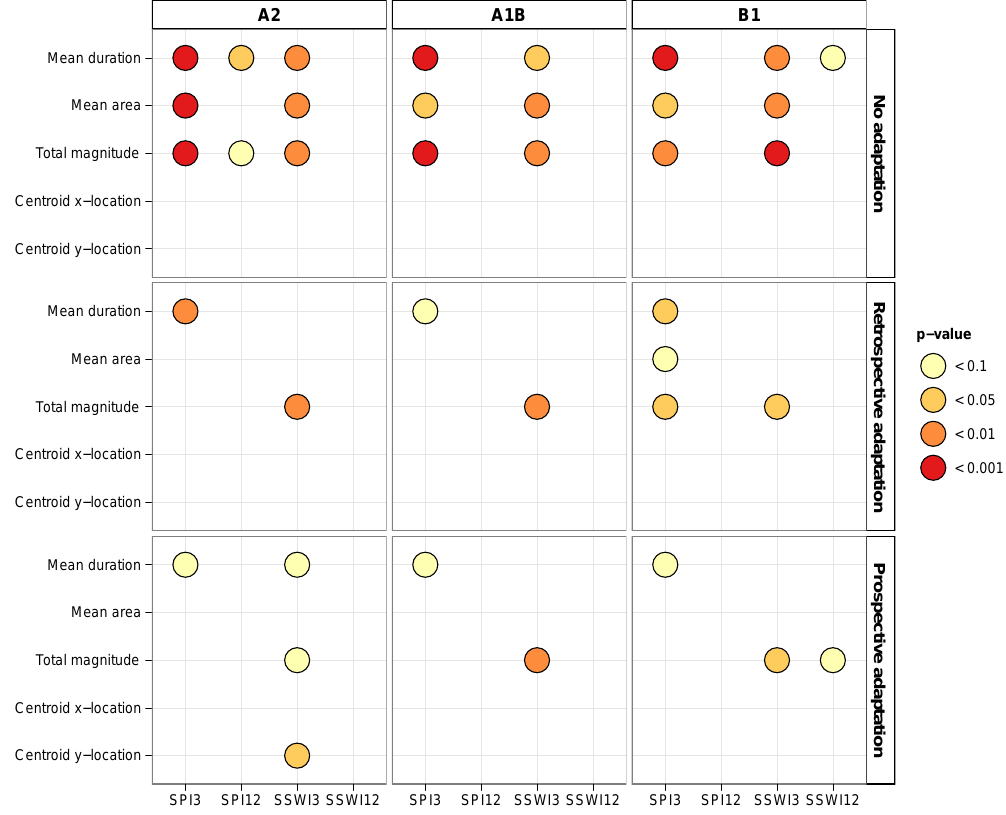
Fig. 11. Significance of the Mann-Kendall trend test (represented with the test p-value) on all combinations of drought indices and spatio- temporal characteristics, for the 3 emissions scenarios (columns) and for the 3 adaptation scenarios